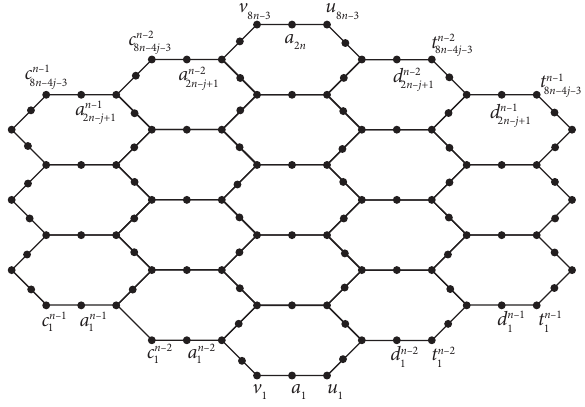
Figure 2: Structure of subdivided honeycomb network SHCN ( n )